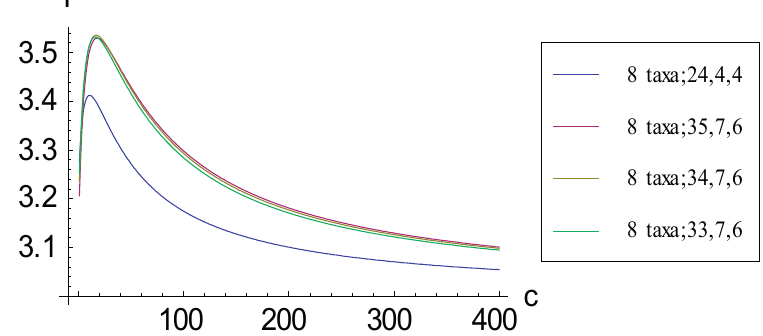
Figure 9. Plots relating information measure I and added autapomorphic characters c for 4 consistent basal matrices for eight taxa. The axes have been extended with respect to the plot in Figure 8 to reveal how I plots become asymptotic as c becomes very large. In this case, because the representations involve eight taxa, the plots asymptote to three bits. At c = 400, the I for (8 taxa; 24, 4, 4), (8 taxa; 35, 7, 6), (8 taxa; 34, 7, 6), and (8 taxa; 33, 7, 6) are 3.0542, 3.1006, 3.0981, and 3.0943; at c added = 5000, they would be 3.0047, 3.0089, 3.0087, and